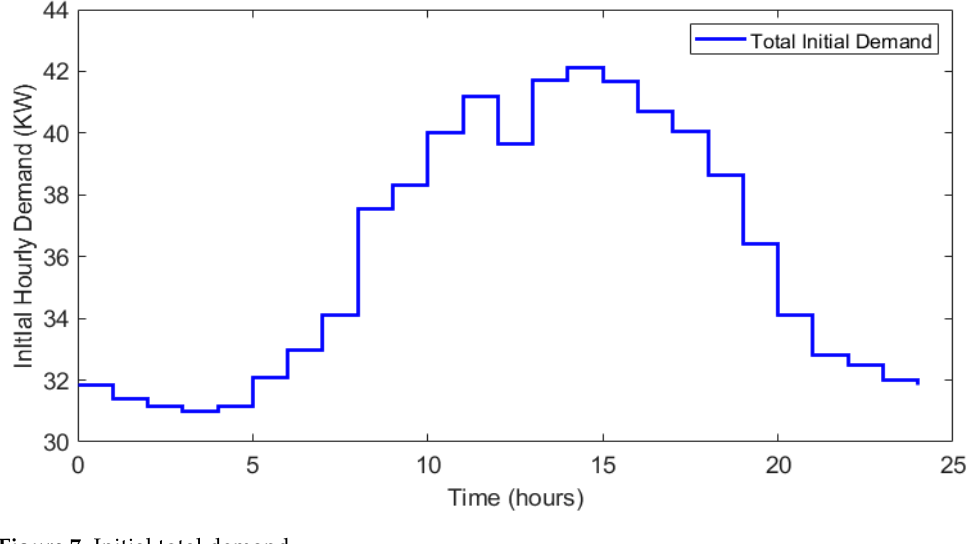
Figure 8. Optimal hourly output power of the conventional generator.